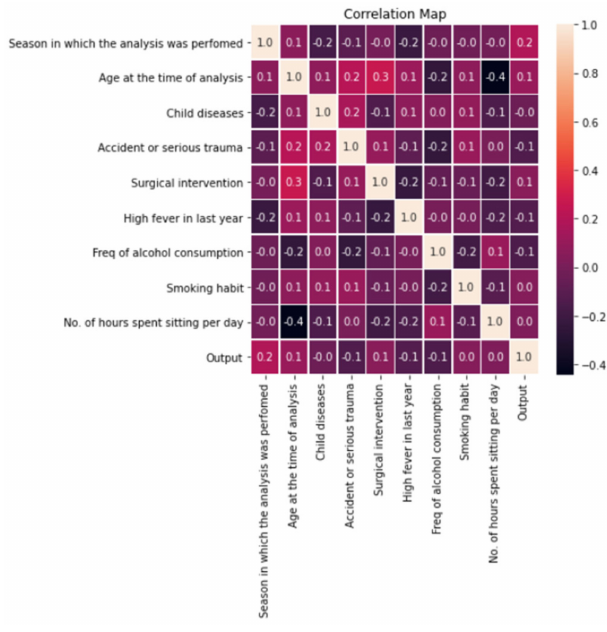
Figure 2. Correlation coefficient